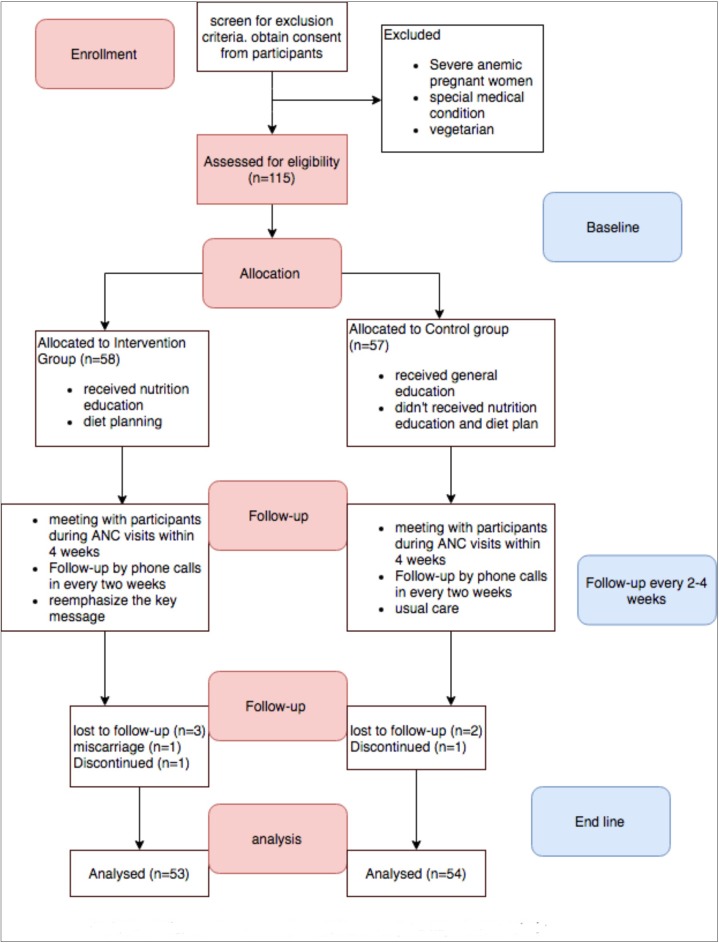
Flow diagram of the study.